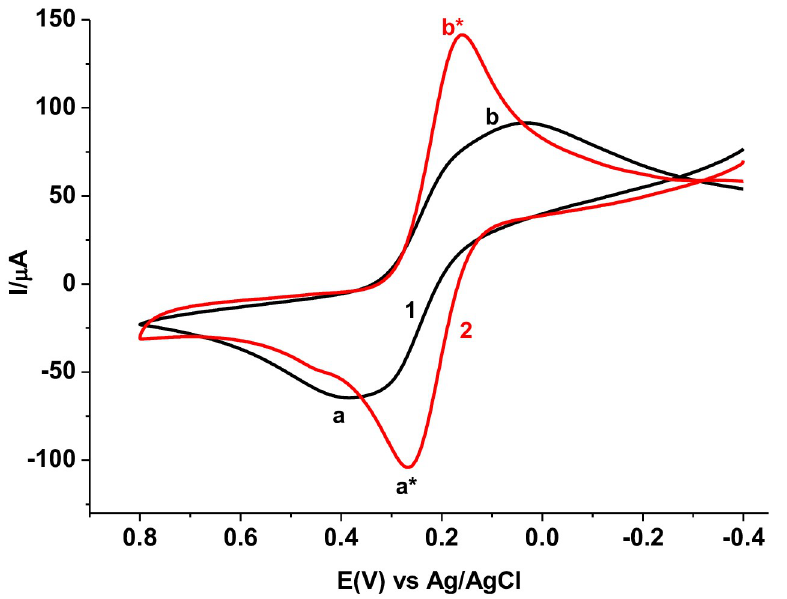
Fig 2. Cyclic voltammograms of (1) bare GCE and (2) PARS/GCE in pH 7.0 PBS containing 10.0 mM [Fe(CN) 6 ] 3-/ 4- and 0.1 M KCl. Scan rate 100 mV s -1 .